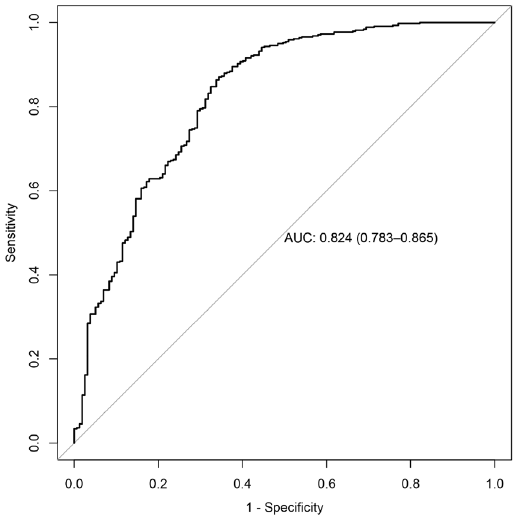
Figure 3. ROC curve representing the classification power of a panel composed of C3, ITIH1 and S100A6 profiles to discriminate between all OA patients and healthy control individuals analysed in this